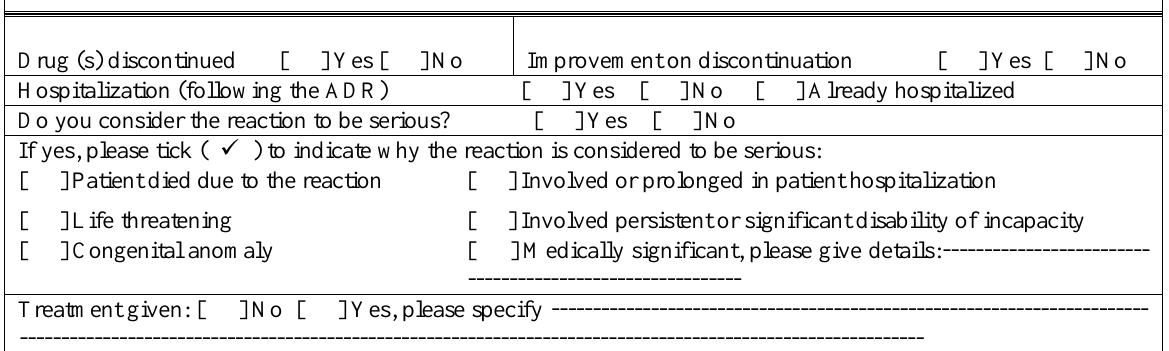
Figure 1.Seriousness assessment in the Iraqi ICSR (3) Action taken